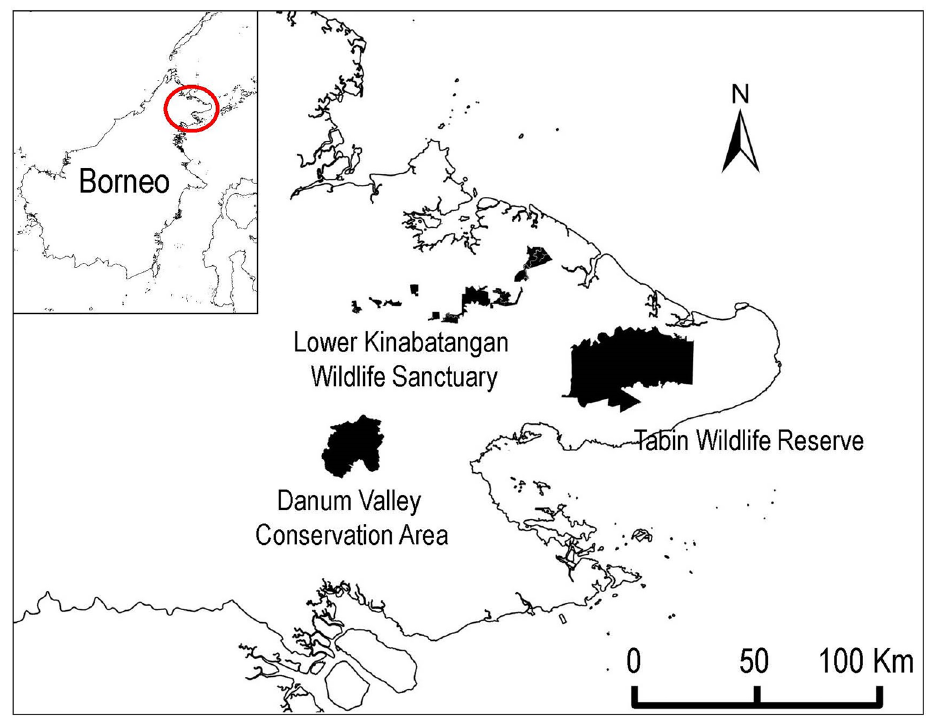
Figure 4. Location of the three study sites in